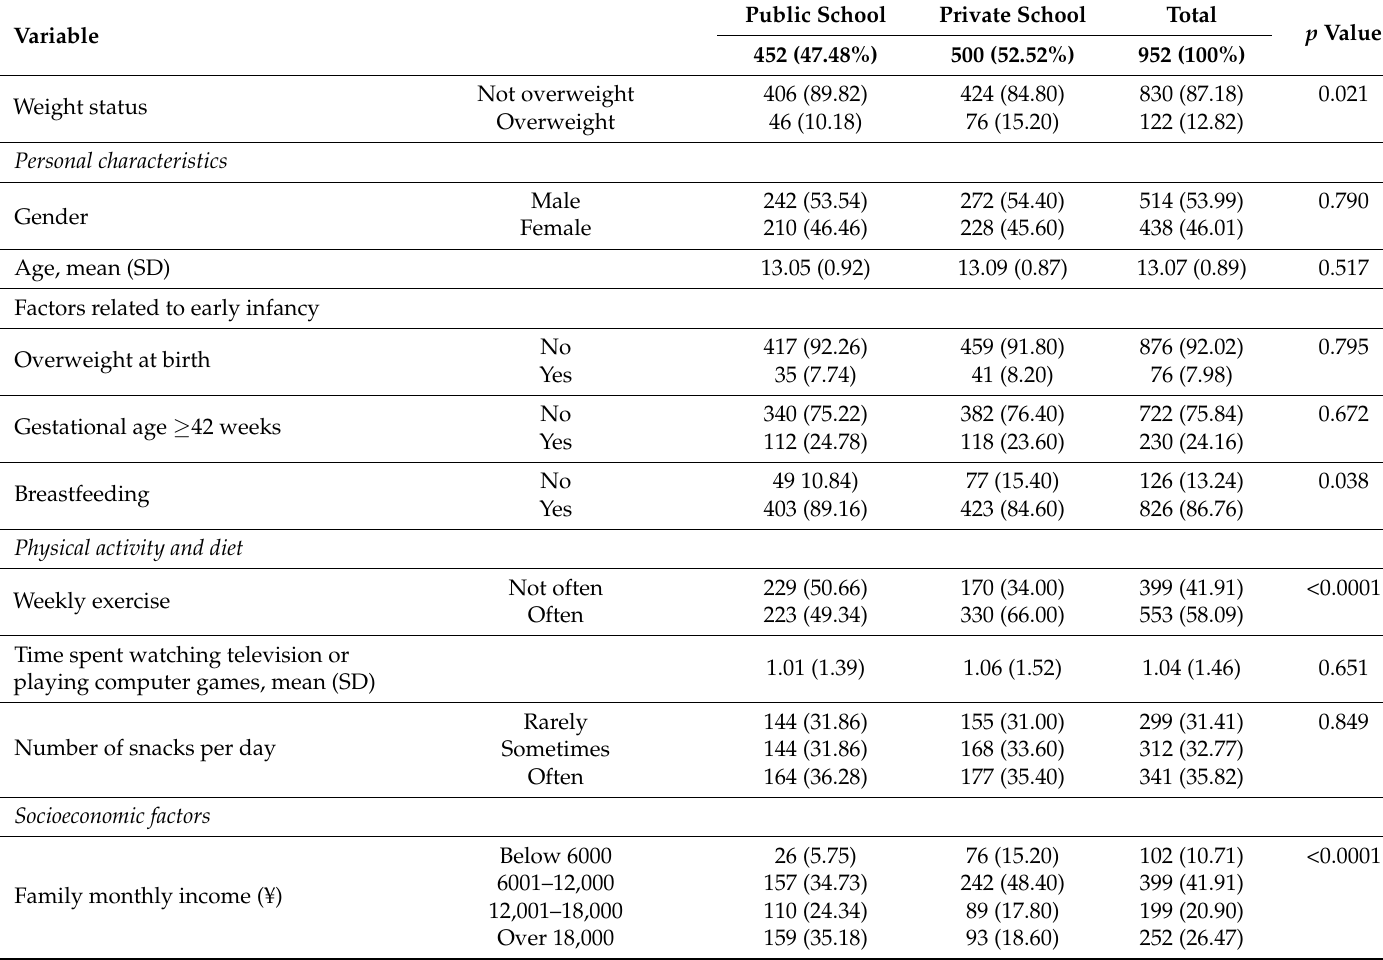
Table 1. Description of the respondents ( n = 952), n